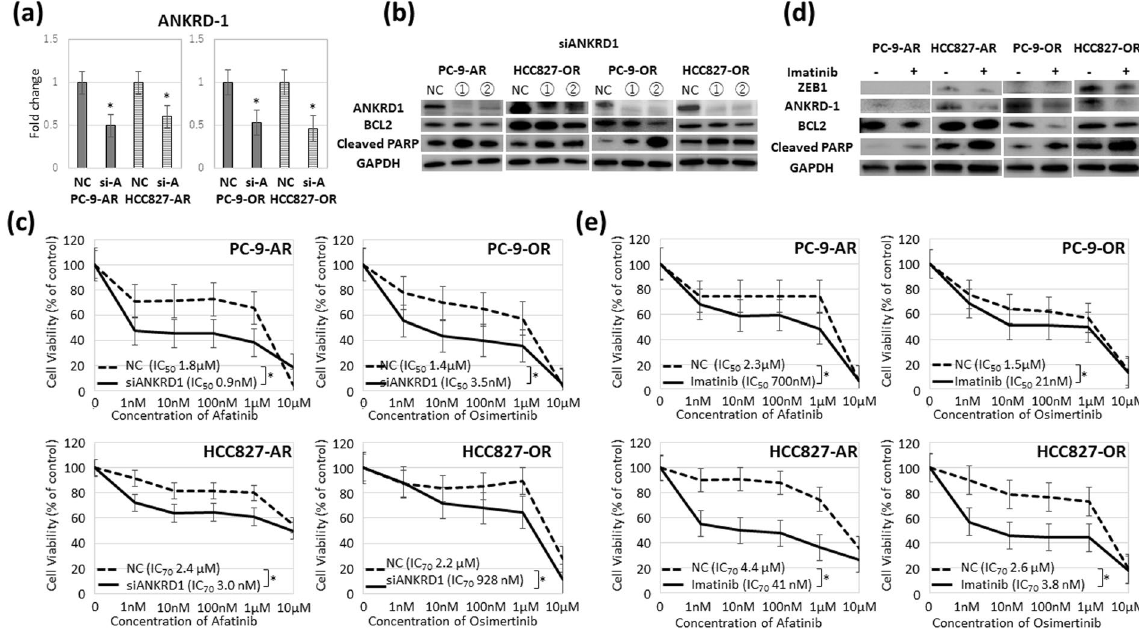
Figure 3. Suppression of ANKRD1 overcame the resistance to EGFR-TKIs. ( a ) ANKRD1 levels in PC9-AR, HCC827-AR, PC9-OR and HCC827-OR before and after siANKRD1-2 transfection by qRT-PCR. * p < 0.01. ( b ) Western blot analysis of BCL-2 and cleaved PARP after ANKRD1 silencing. ANKRD1 was silenced after siANKRD1 transfection for 96 hours. ( c ) The dose-dependent sensitivity to afatinib and osimertinib in the resistant cell lines after ANKRD1 siRNA treatment. * p < 0.01. ( d ) Afatinib and o simertinib-resistant cell lines were treated with afatinib (500 nM) or osimertinib (500 nM) with or without imatinib (1 μM) for 24 hours. ( e ) The dose-dependent sensitivity to afatinib and osimertinib in the resistant cell lines with or without imatinib. NC: siRNA negative control, si-A: siANKRD1-2 * p < 0.01.